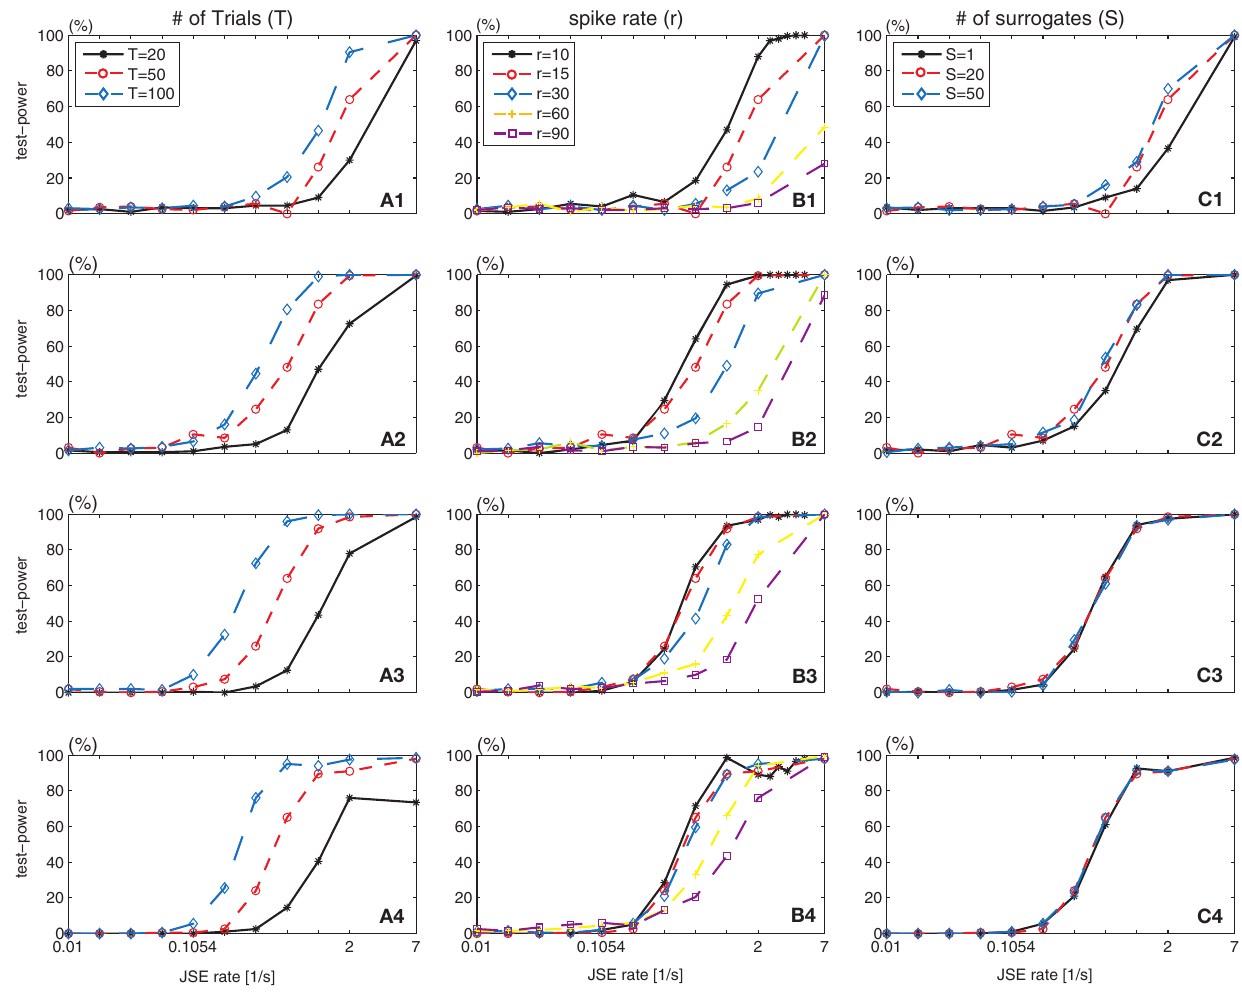
Figure 4 | Test power of bivariate NeuroXidence in relation to the number of trials ( T ), spike rate ( r ), and number of surrogates ( S ). Rows 1–4 show the test-power dependencies on the complexities of the analyzed JS-patterns with complexities from 2 to 5. (A1–A4) Variations in the number of trials T , (B1–B4) variations in the background spike rate r , and (C1–C4) variations in the number of surrogates S from the standard parameter set ( T = 50, r = 15 spikes/s, S = 20, h = 5, l =